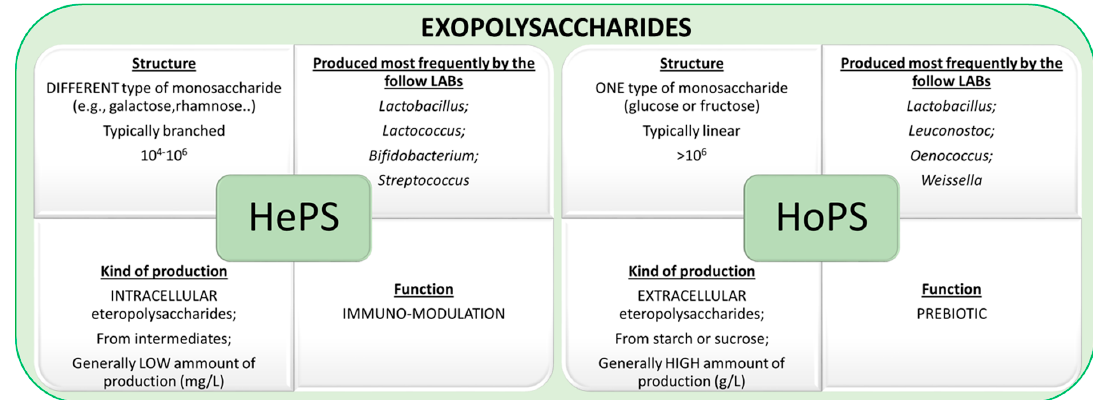
Figure 2. Schematic description of exopolysaccharides, including principal information about structure, production, and main function of EPSs.